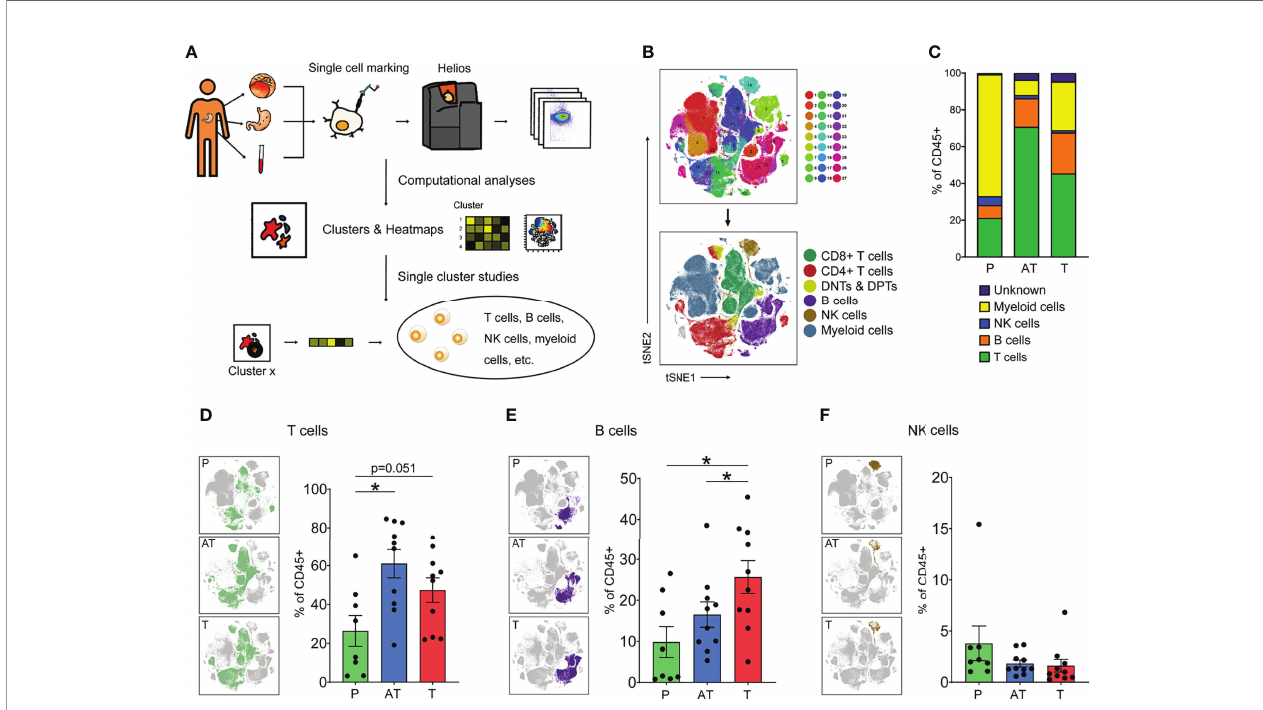
FIGURE 1 | The immune landscape of human gastric cancer (GC) by CyTOF. (A) Experimental approach of the study. (B) tSNE maps displaying immune cells of GC patients colored by 27 Phenograph clusters (top) and the main cell populations by manual identi fi cation of Phenograph clustering (below). (C) Average frequencies of major immune lineages for each type of sample (peripheral blood mononuclear cells [PBMCs, P], n = 8; adjacent tissues [AT] and tumor tissues [T], n = 10) across GC patients. (D – F) Distribution of the T (D, B, E) , and NK (F) cells in different types of samples (left) and frequency of that for each patient (right) based on manual identi fi cation of Phenograph clusters. Bar plots show mean ± SEM; *p < 0.05 by paired t-test. P, peripheral blood mononuclear cells (PBMCs); AT, adjacent tissues; T, tumor